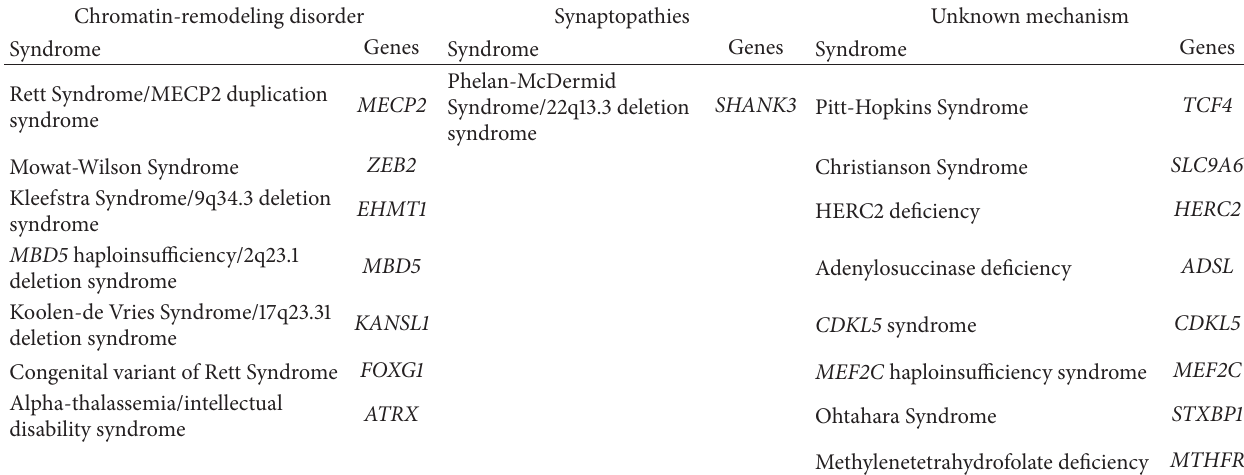
Table 1: Angelman-like